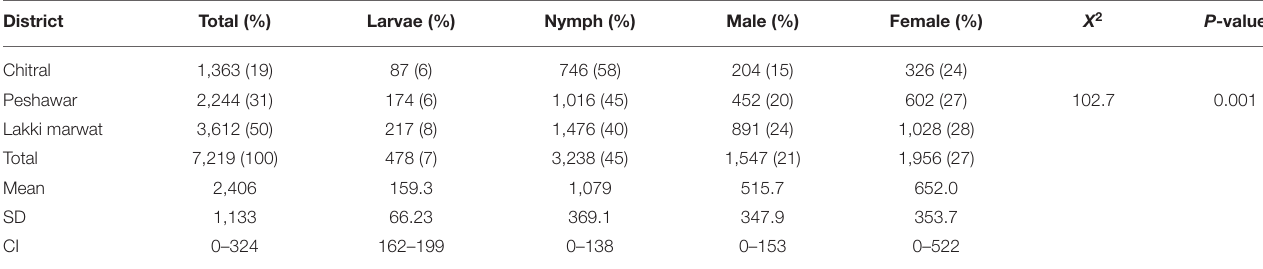
TABLE 1 | The abundance of different stages of collected Argas persicus ticks. District